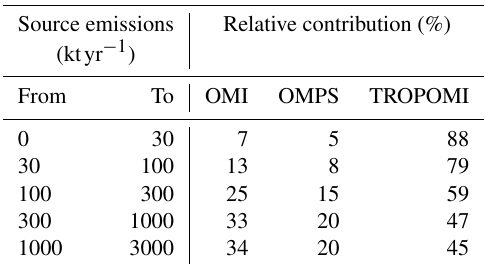
Table 1. Relative contribution of individual satellite instruments to the weighted average for emissions estimate depending on the emis- sion strength for